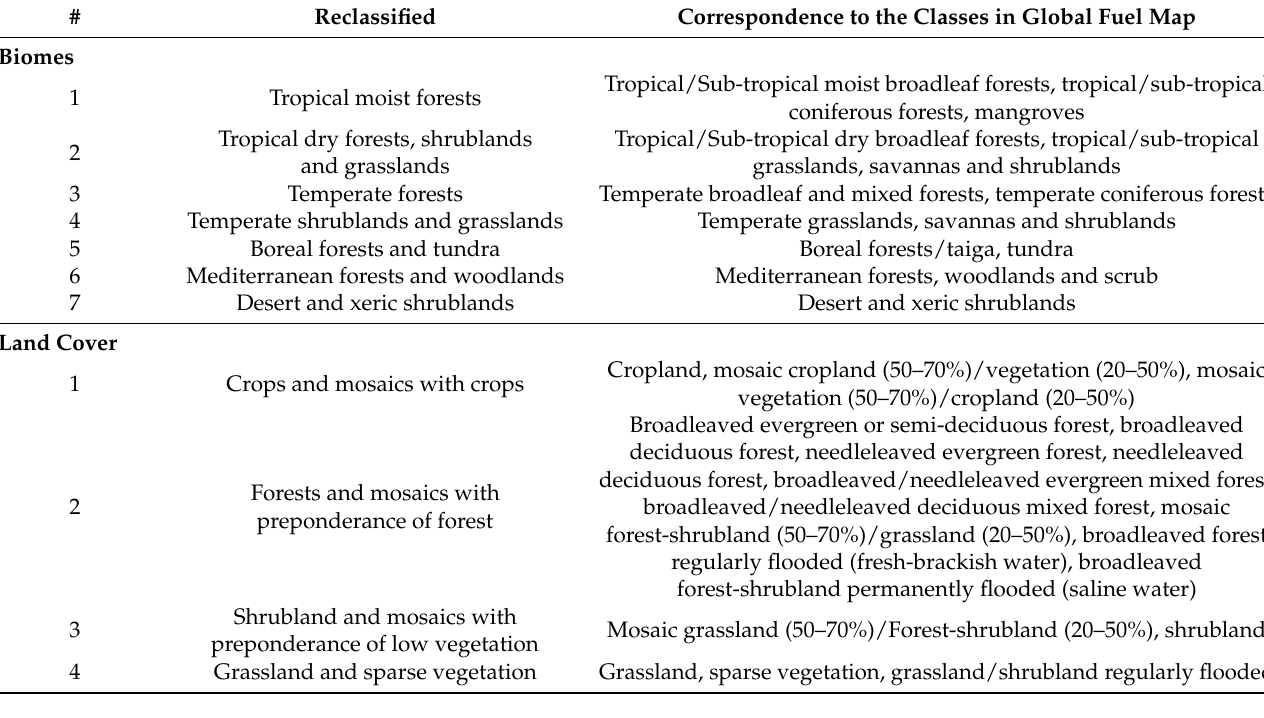
Figure A5. Spatial distribution of the fire radiative power (see main text for definition and further details). The bottom panel shows a zoomed region in central South America, as delineated in the global map. Table A1. Reclassification of the biomes and land cover classes of the global fuel dataset [43]. The classes correspond to the ones shown in Figure 5 of that